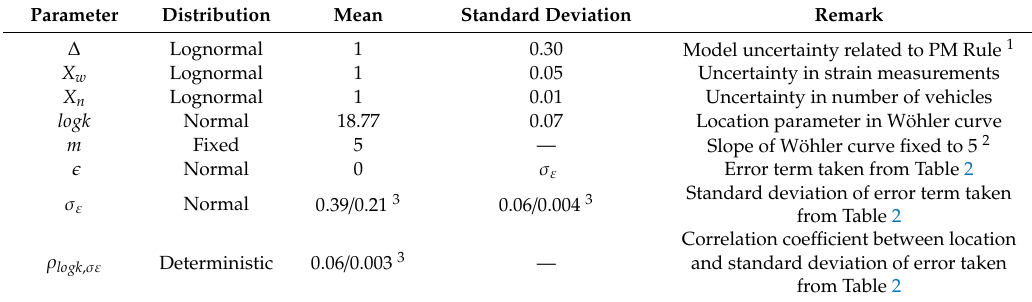
Table 3. Stochastic model for Wöhler curve.